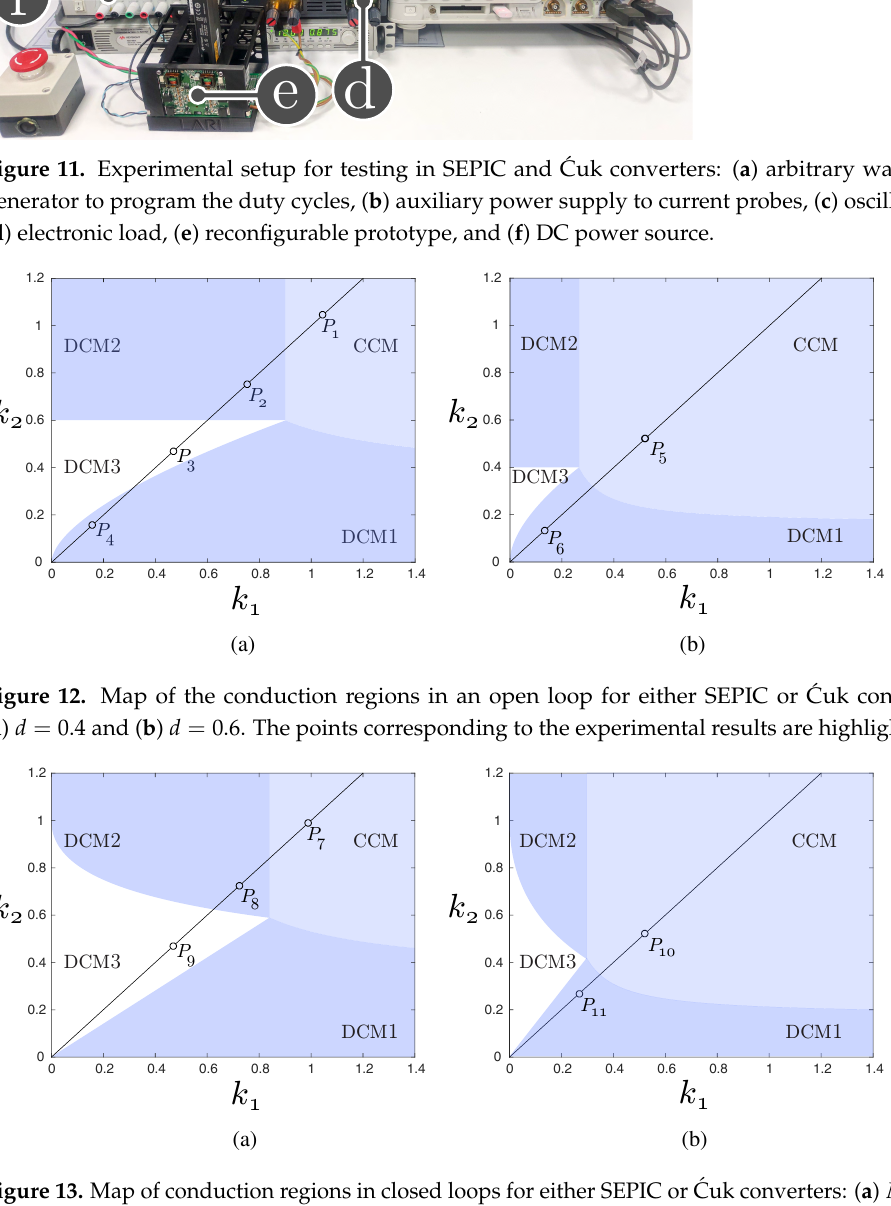
Figure 13. Map of conduction regions in closed loops for either SEPIC or ´Cuk converters: ( a ) M = 0.7 and ( b ) M = 1.4. The points corresponding to the experimental results are